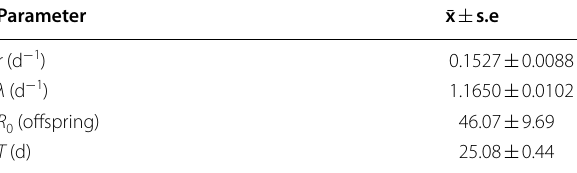
Table 6 Population parameters intrinsic rate of increase ( r ), finite rate of increase ( λ ), net reproductive rate ( R generation time ( T ) of Leptomastix dactylopii